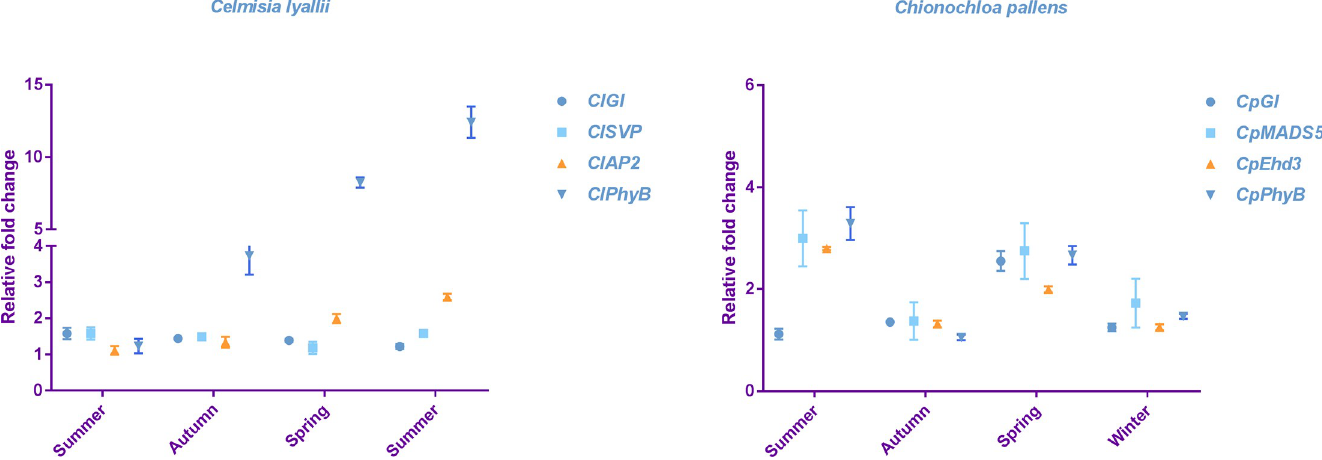
Fig 8. Seasonal gene expression analysis of selected flowering-pathway genes in C . lyallii and C . pallens . The relative expression was calculated using 2 - ΔΔ Ct method, represented by data from two biological replicates with three technical replicates ±